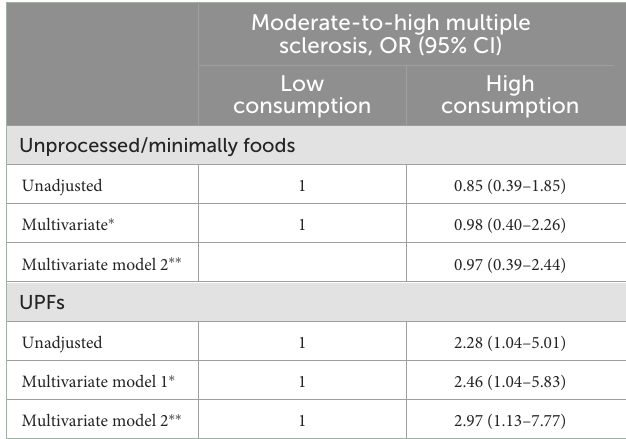
TABLE 4 Mean daily intake (and standard deviations) of major macro- and micronutrients by multiple sclerosis status. Nutrients Multiple sclerosis